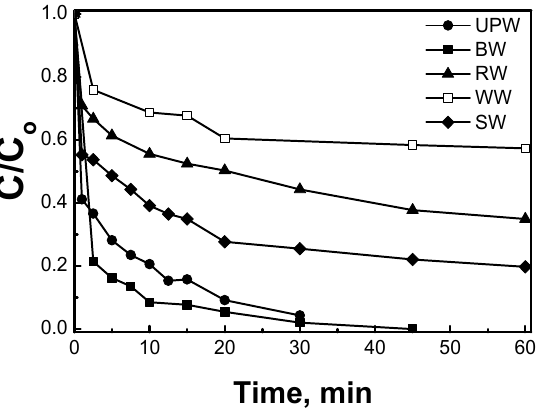
Figure 9. Effect of water matrix on the degradation of 0.5 mg L − 1 SMX with 100 mg L − 1 biochar and 250 mg L − 1 SPS at inherent pH.